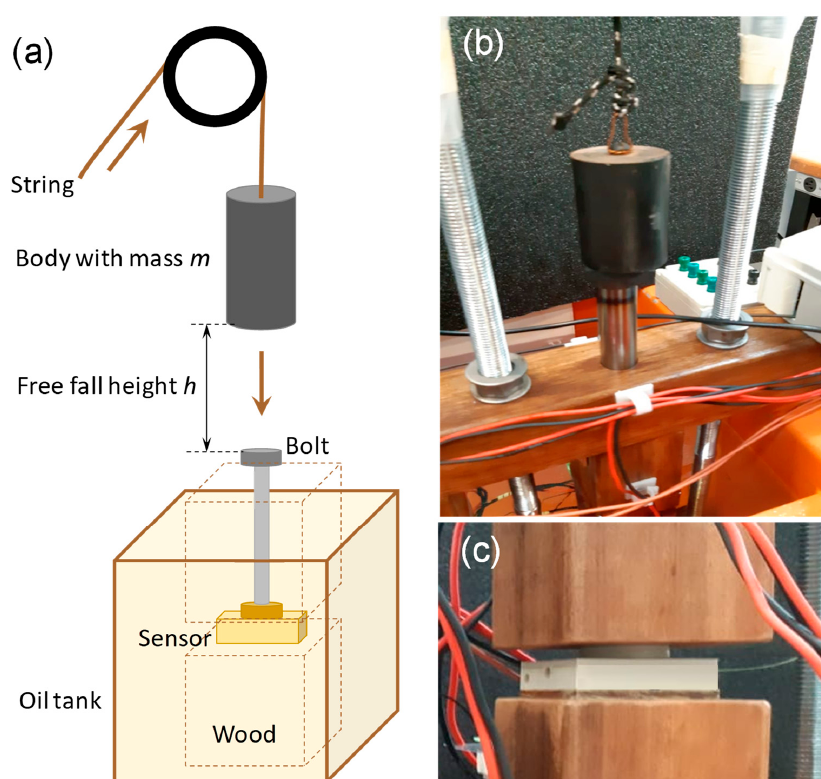
Figure 9. ( a ) Dynamic test set-up arrangement that aims to simulate the shims loading conditions within a power transformer. ( b ) Free-fall body and ( c ) deformation sensor.